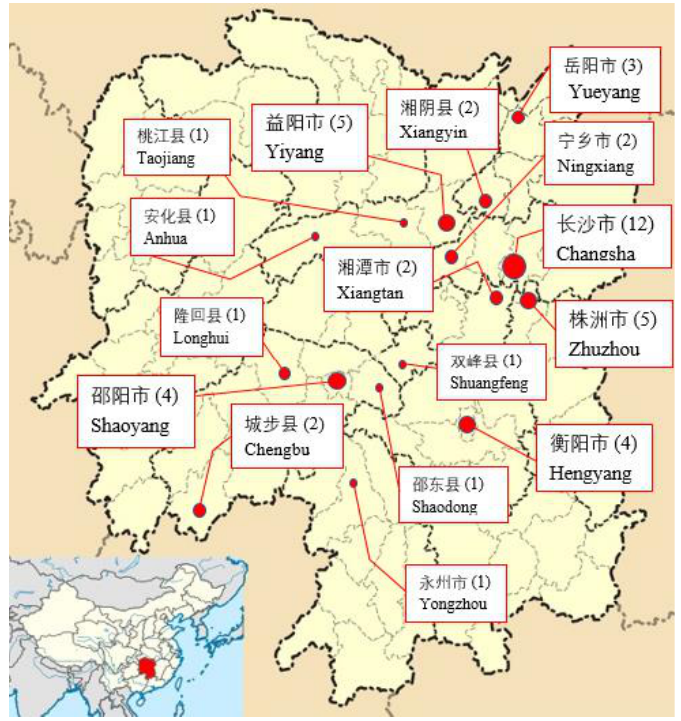
Figure 4. Dialect areas represented by the sample (no. of speakers in parentheses).